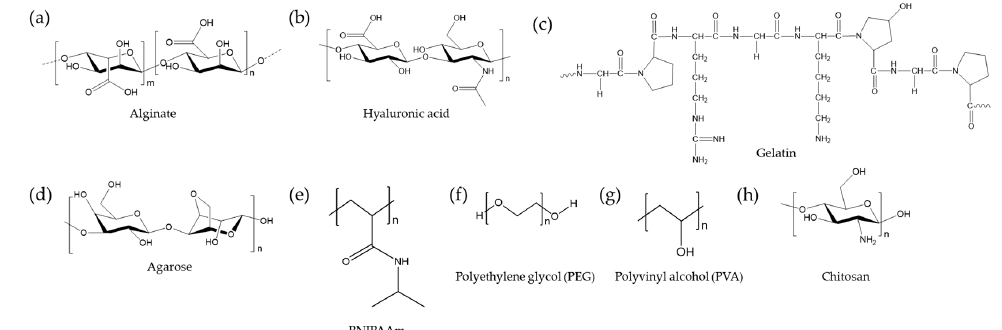
Figure 2. Common polymers used for hydrogels and cell delivery.